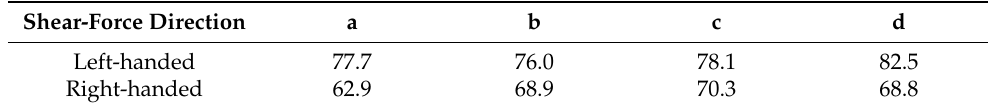
Table 2. F1 scores of shear-force direction by dominant hand (%). Shear-Force Direction